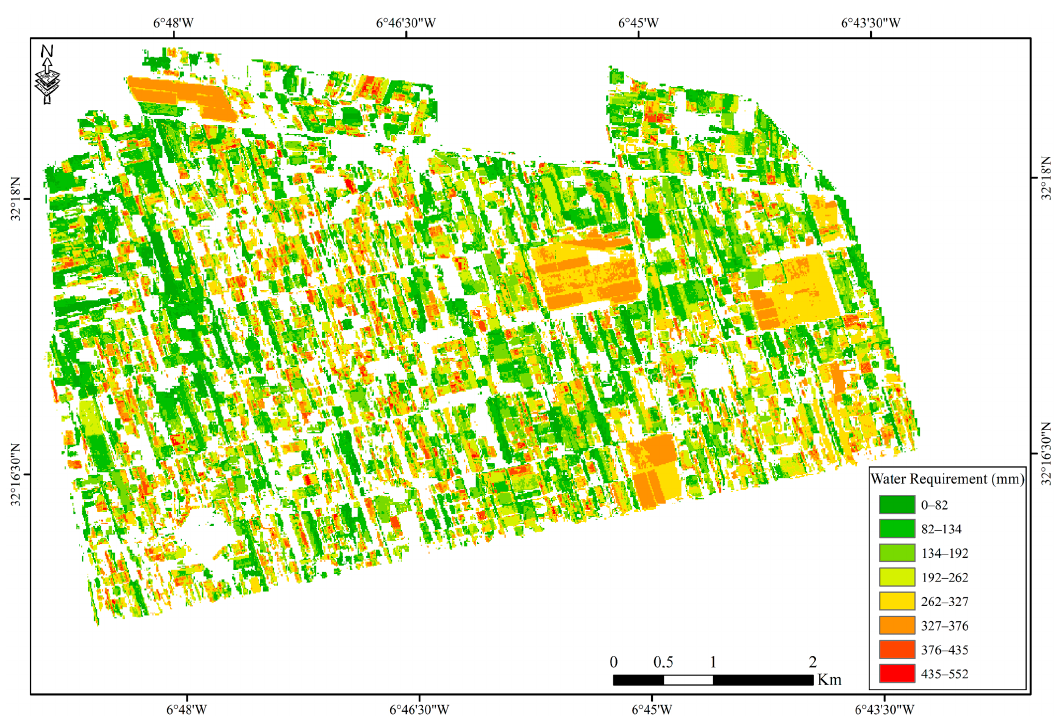
Figure 9. Crop water requirements during the 2016–2017 agricultural season in the study area .